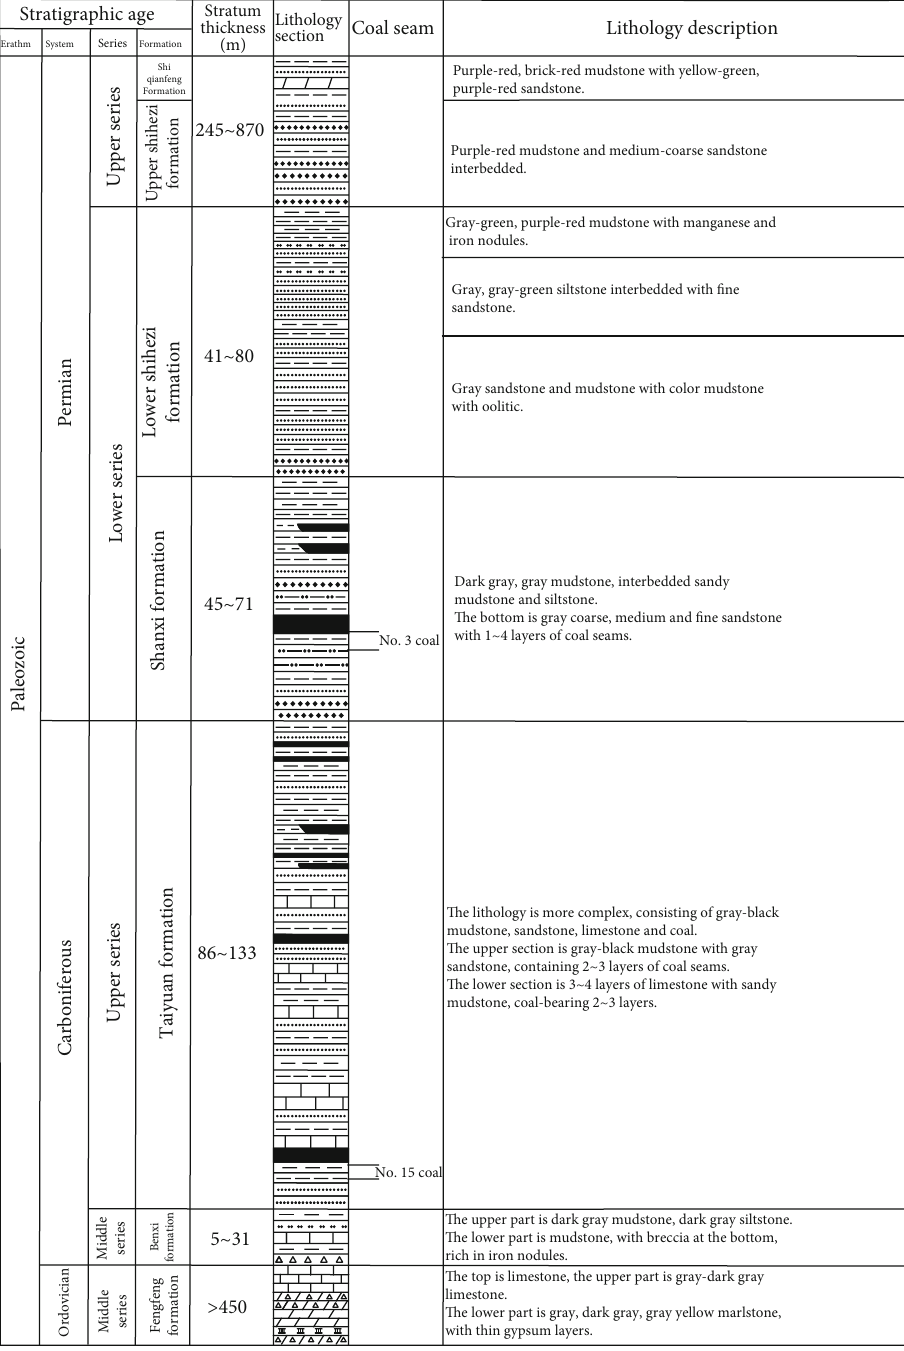
seams.Purple-red, brick-red mudstone with yellow-green, purple-red sandstone.